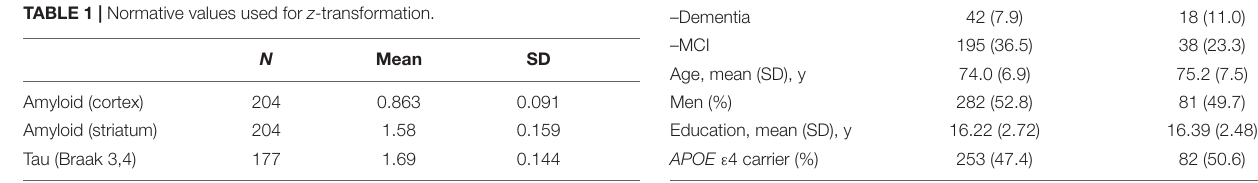
calculated based on the same ADNI data (Landau and Jagust, 2015), was found to be 1.043 for the CIVET-based cortical SUVR by regression analysis. The cortical A β cutoff of 1.043